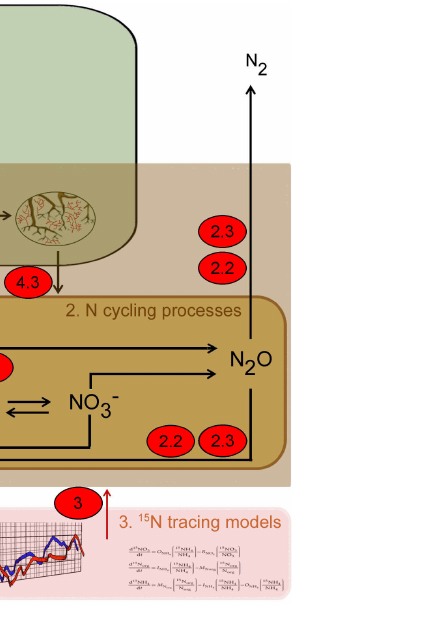
Figure 1. New insights and key challenges with respect to the soil N cycle, as identified in this paper. These include three N cycling processes (Sects. 2.1–2.3), a modelling challenge (Sect. 3), and four pathways through which ecological interactions might affect N cycling processes (Sects.